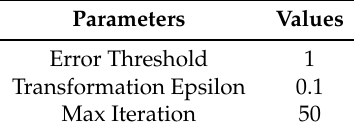
Table 1. Normal Distribution Transform (NDT) Matching Experimental Parameters.